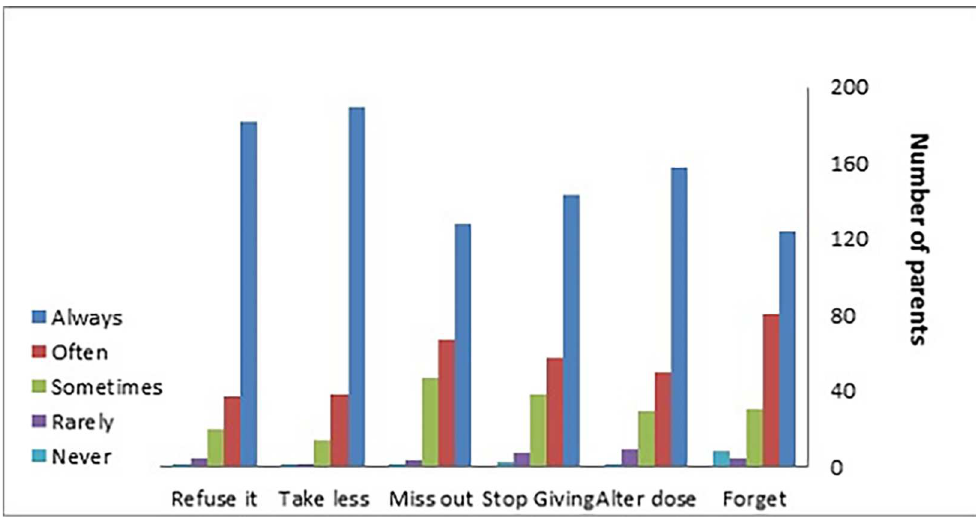
Fig 3. Parent reported adherence of their child to their medication [n = 249].